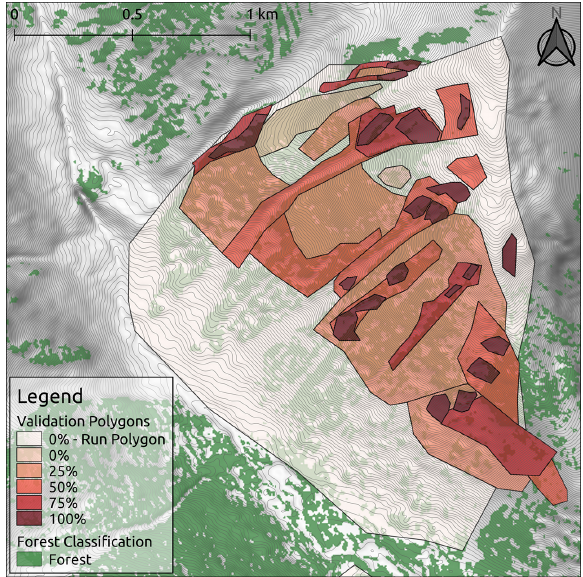
Figure 6. Validation polygons from one run at CMH Galena. Poly- gons are color-coded based on the release area proportion of each polygon. Forest data created using Planet Labs RapidEye imagery (Planet Team,